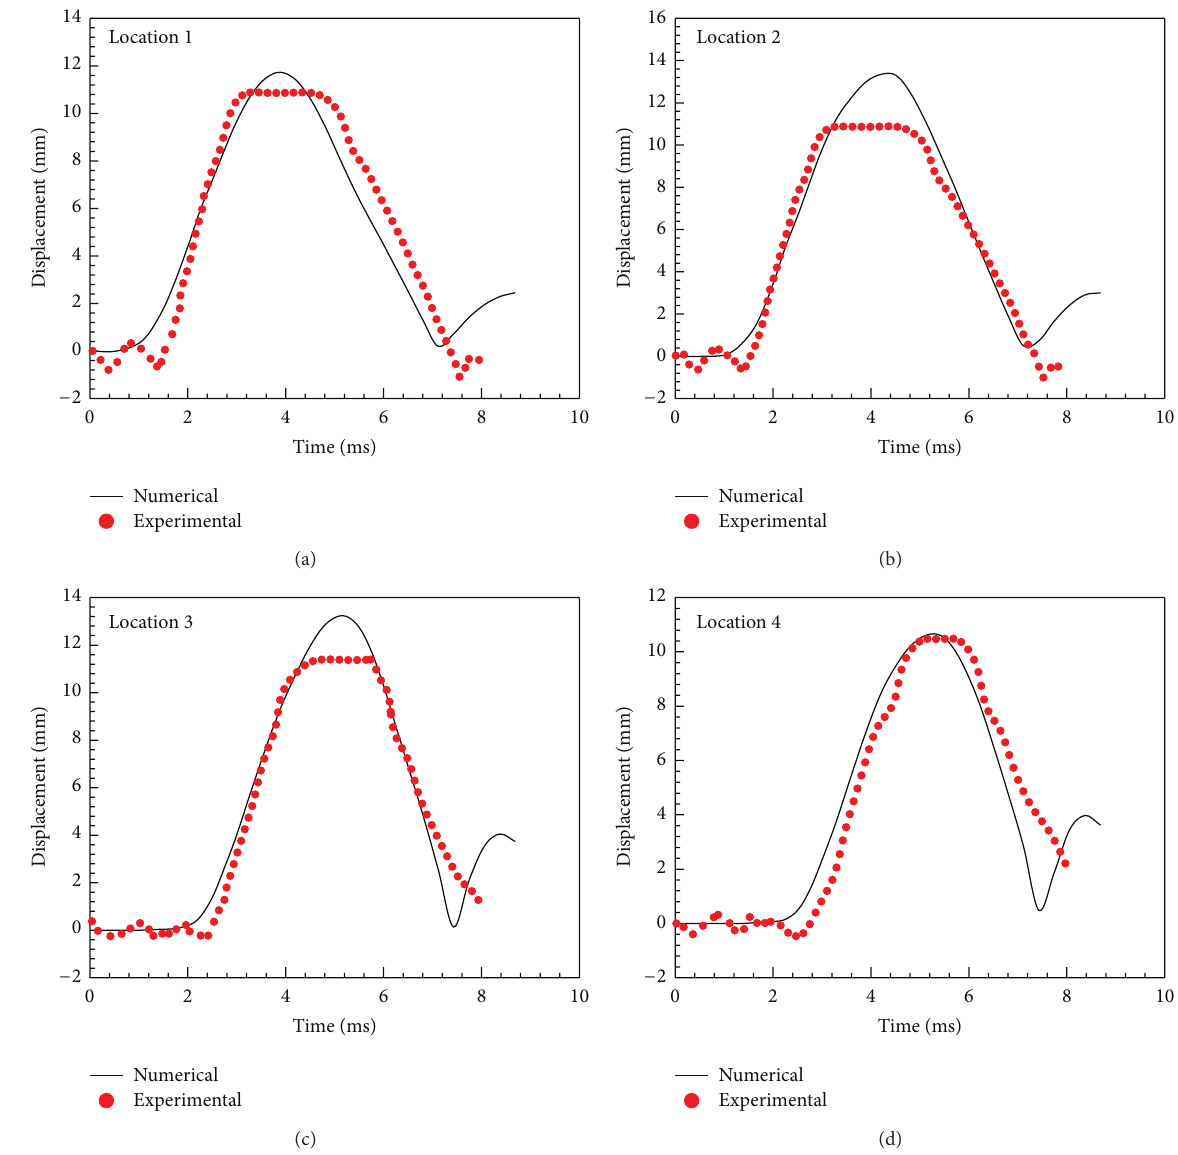
Figure 7: Displacement time plots for various locations on